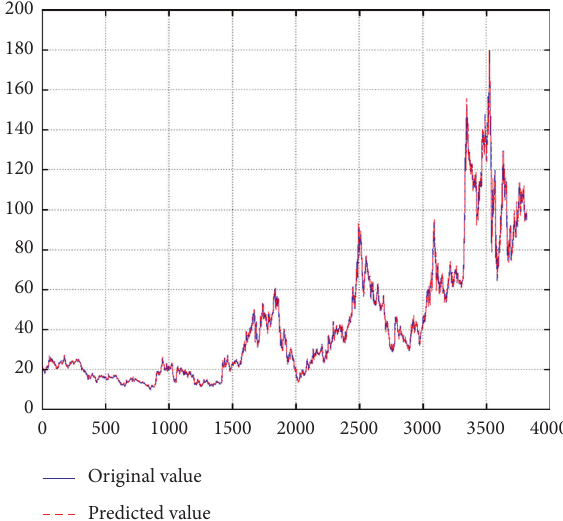
Figure 9: Elman model fitting